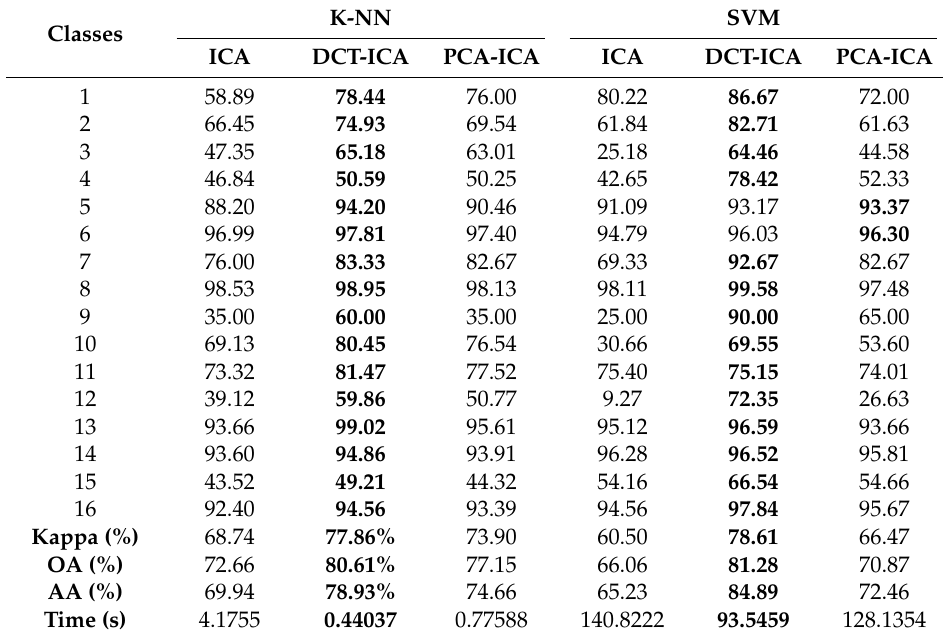
Table 4. Classification accuracy (%) using K-NN and SVM classifiers on the Indian Pines Dataset.